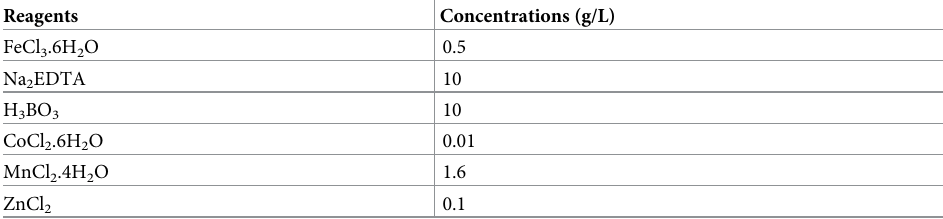
Table 2. The metal mixture compositions in defined medium. Reagents